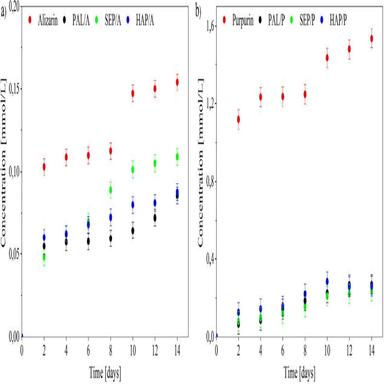
Migration of natural dyes and hybrid pigments from EN composites in ethanol solution.